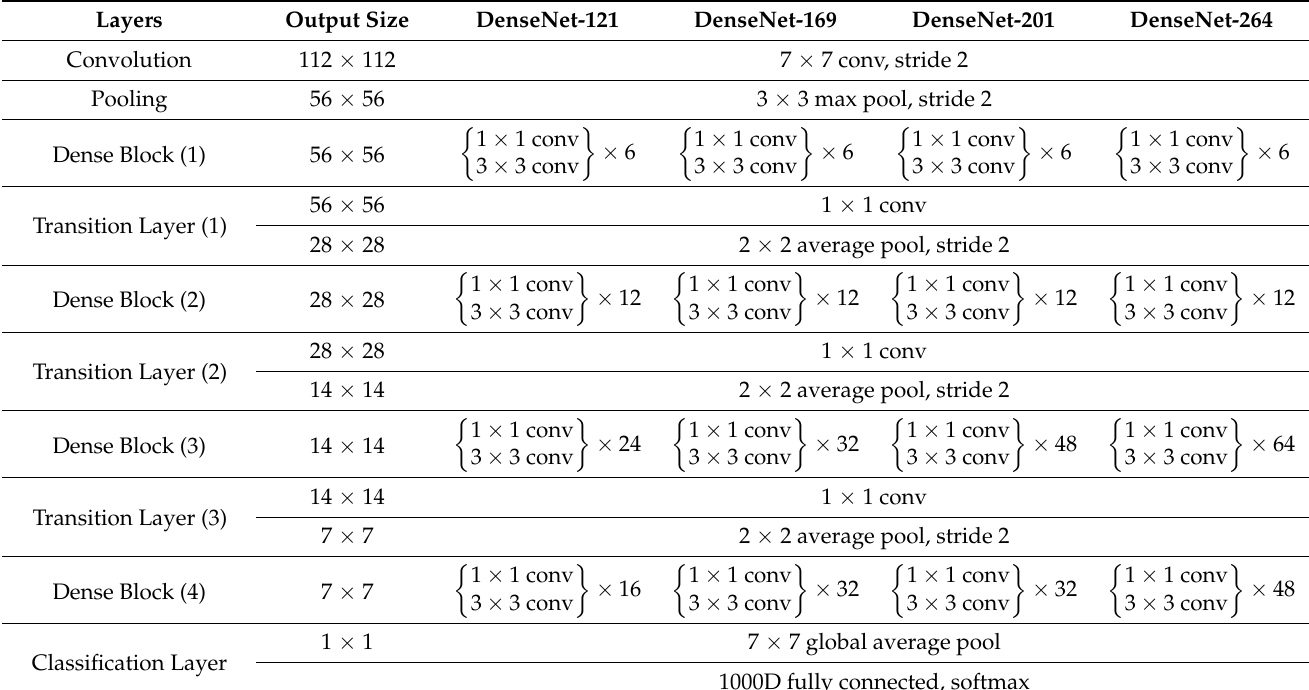
Table 2. Common architectures of DenseNet.